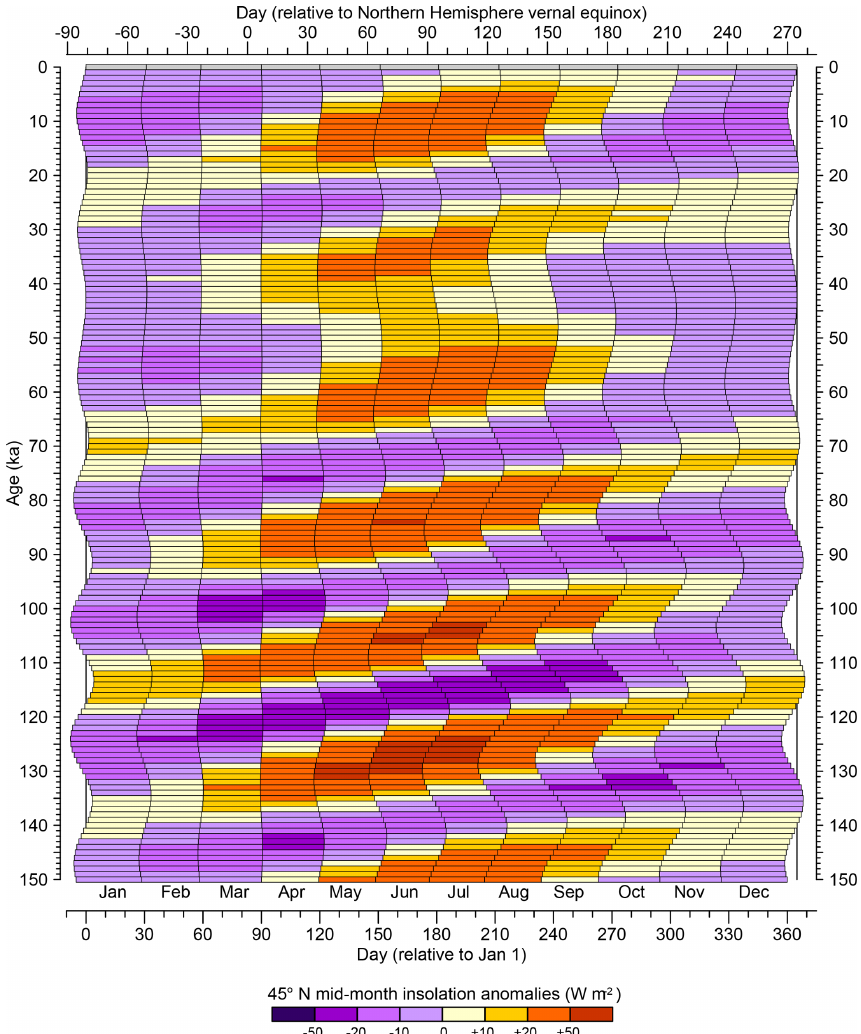
Figure 7. Long-term differences in mid-month average daily insolation relative to present (0ka or 1950 CE) at 45 ◦ N for a fixed-angular calendar. As in Fig. 1, variations over the past 150kyr in the beginning and ending days of fixed-angular months for a 365d noleap calendar are shown for 1kyr intervals beginning at 0ka (1950 CE). The left side of each horizontal bar shows the beginning day, while the right side shows the ending day of a particular month for each 1kyr